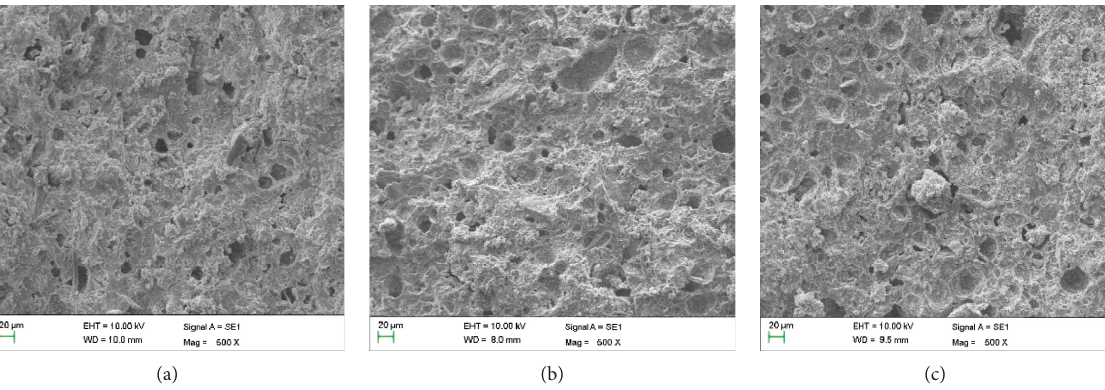
Figure 6: Distribution of droplets in the CST (a), SDT (b) and EST (c) samples.